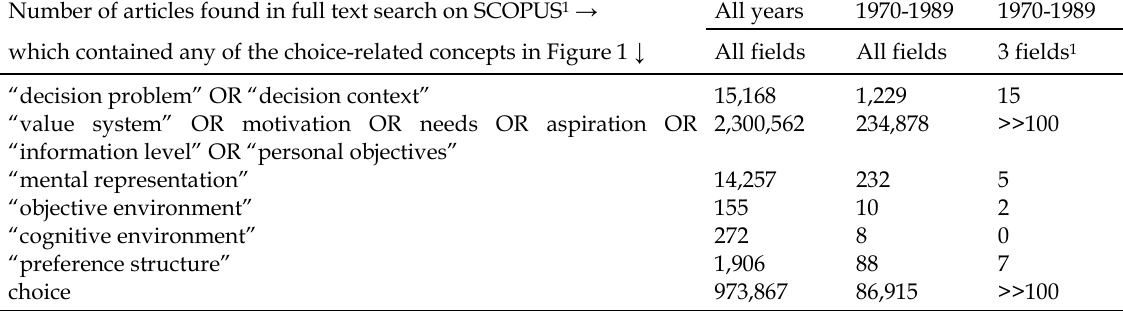
Table 1. Occurrence of keywords in marketing, urban planning and transport literature Number of articles found in full text search on SCOPUS 1 →